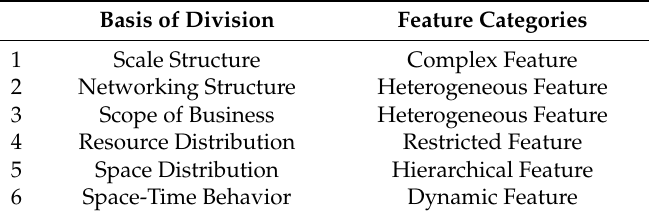
Table 1. Typical Feature Classification of SIN (Space Information